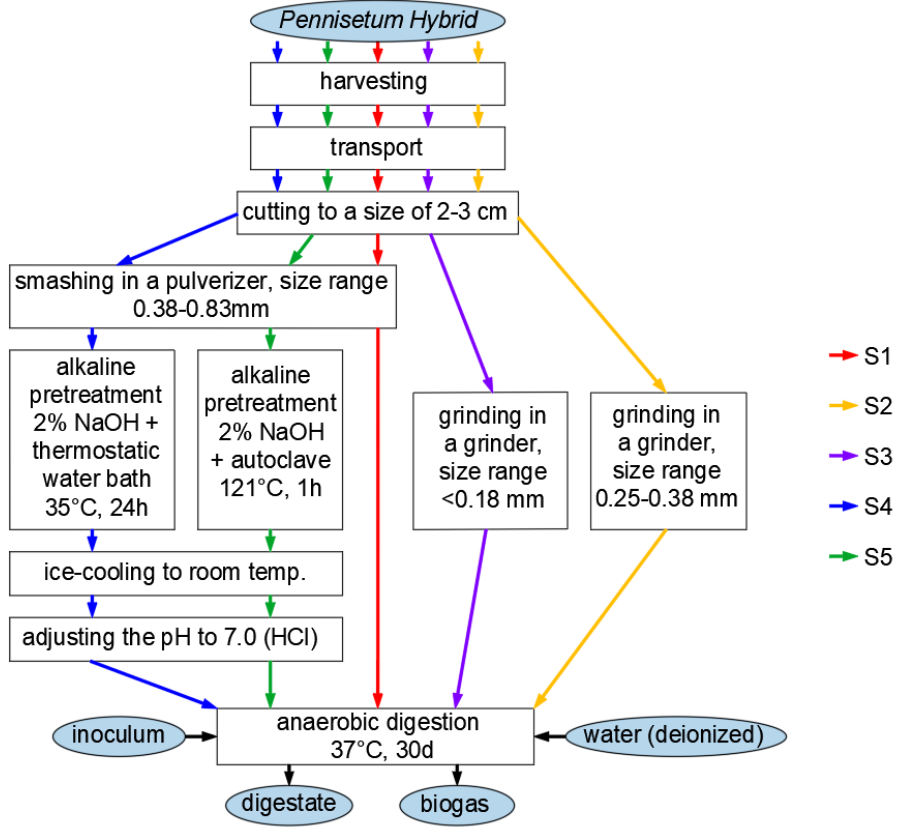
Figure 1. Schematic view of the analyzed processes of pretreatment and anaerobic digestion of Pennisetum hybrid.